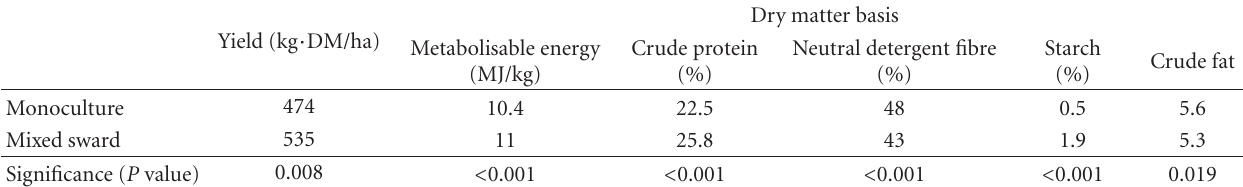
Table 4: Mean pasture quality tests for vegetation treatments, sampled May 17,